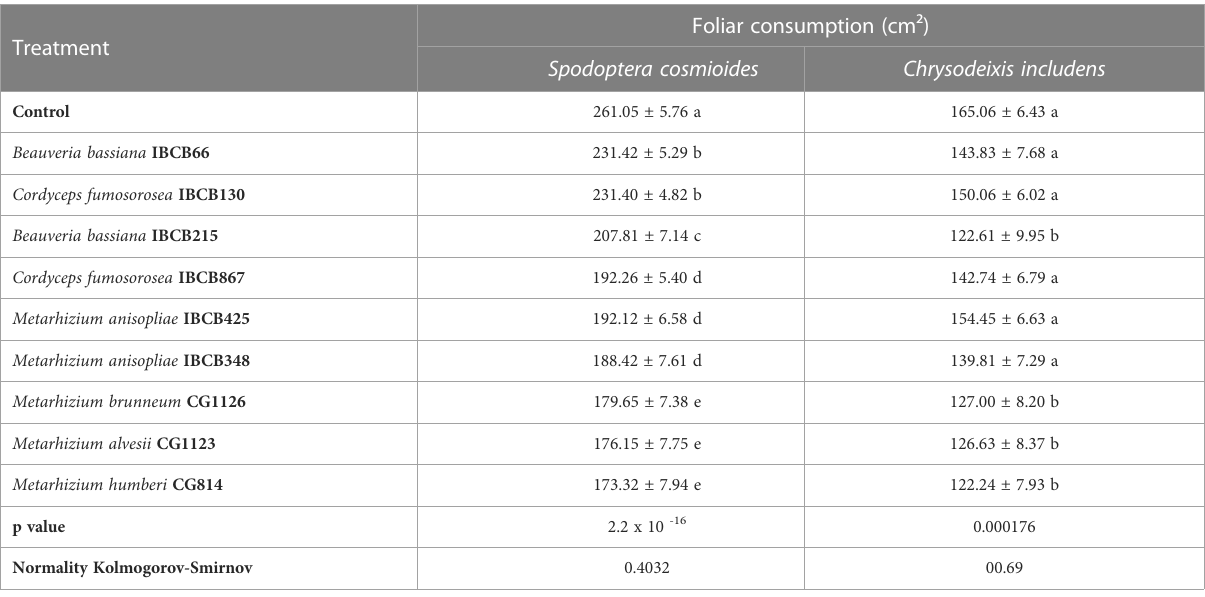
TABLE 5 Cumulative foliar consumption (cm²) of S. cosmioides and C. includens fed with peanut plants inoculated with entomopathogenic fungi and uninoculated control.